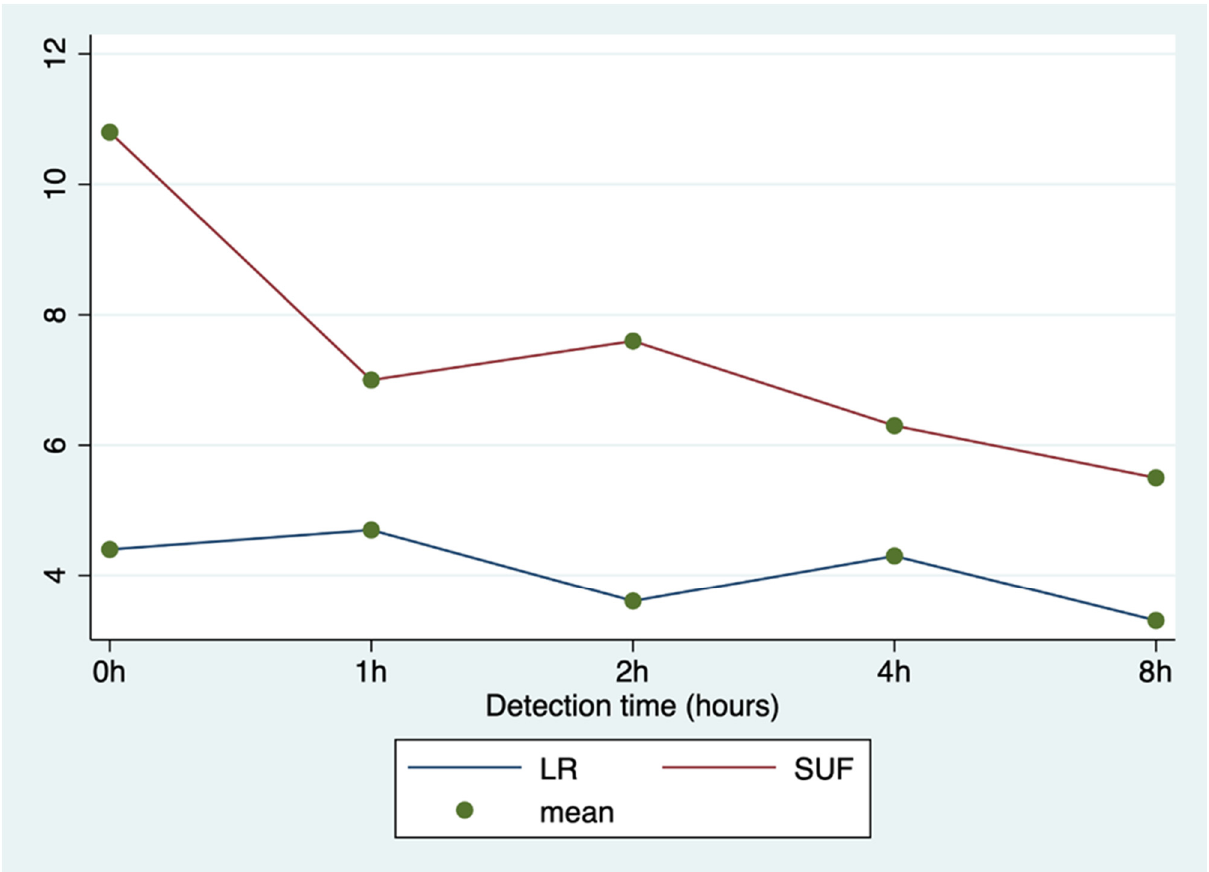
Figure 1. Average UNESP-Botucatu scores by group (LR vs. SUF) at different detection times. The observed events related to methadone administration are described in Table